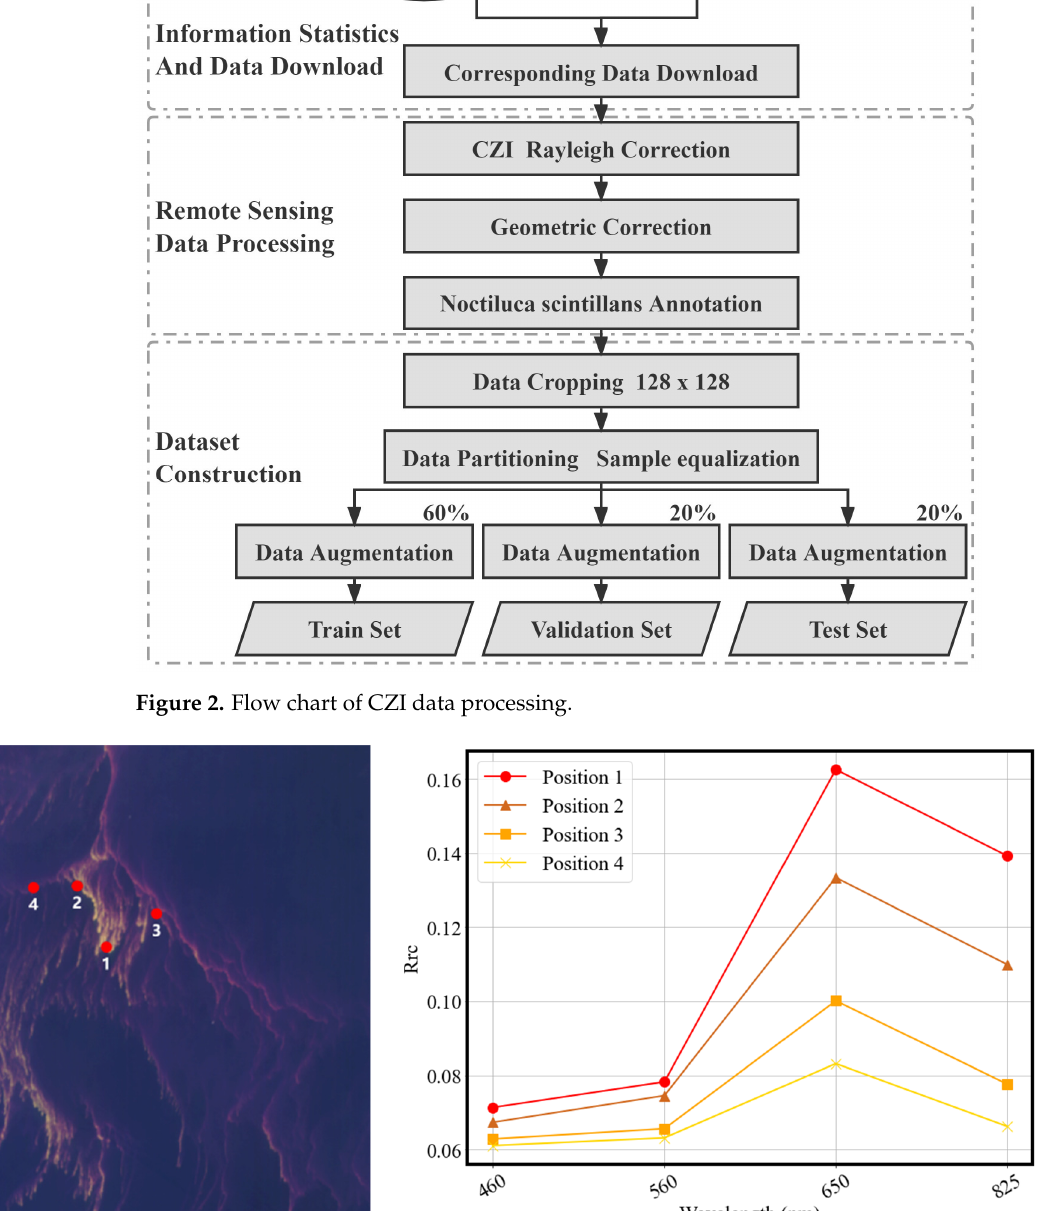
Figure 3. Spectral re fl ectance of NSB at di ff erent locations in the CZI image. ( a ) Locations of four points with di ff erent abundances; ( b ) Spectral re fl ectance of NSB at the four points.